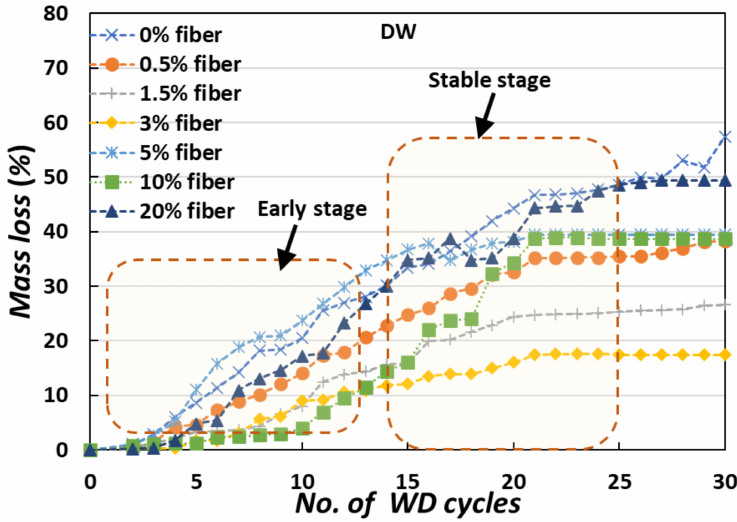
Figure 4. The average weight loss of the MICP-treated samples exposed to cyclic WD treatments (DW cases).